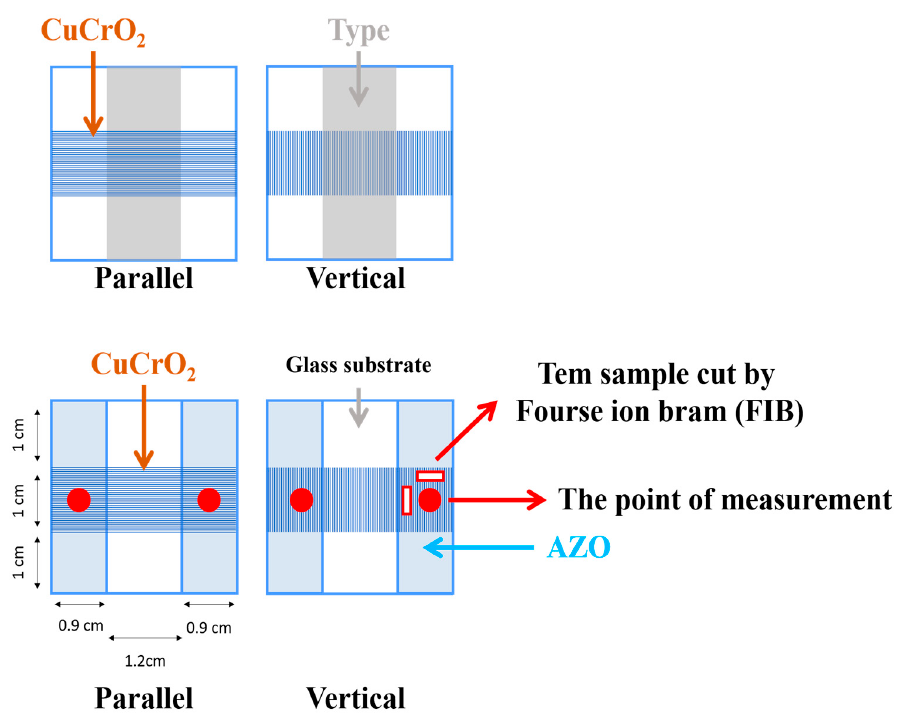
Figure 12. Schematic diagram of the resistivity in the vertical and parallel directions of CuCrO 2 thin films annealed at 600 °C at different rotating speeds from 100 to 3000 rpm measured by FIB.